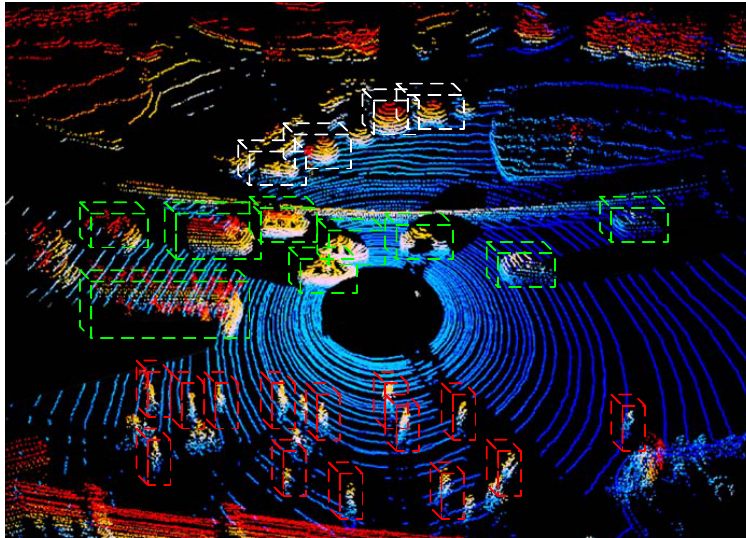
Figure 2. The 3D LiDAR data. Trees are bounded by white cubes, vehicles by green cubes and pedestrians by red cubes. The black zones are the blind spots of LiDAR.